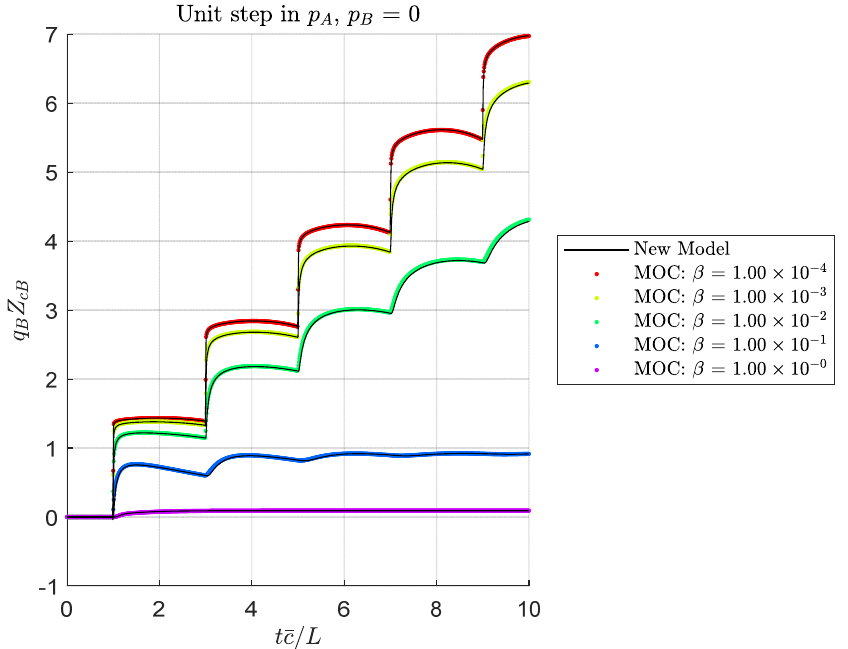
Figure 8. Outlet flow response to a unit step in inlet pressure for an open exit, showing the effect of dissipation number (for c B c A = 0.5 ).